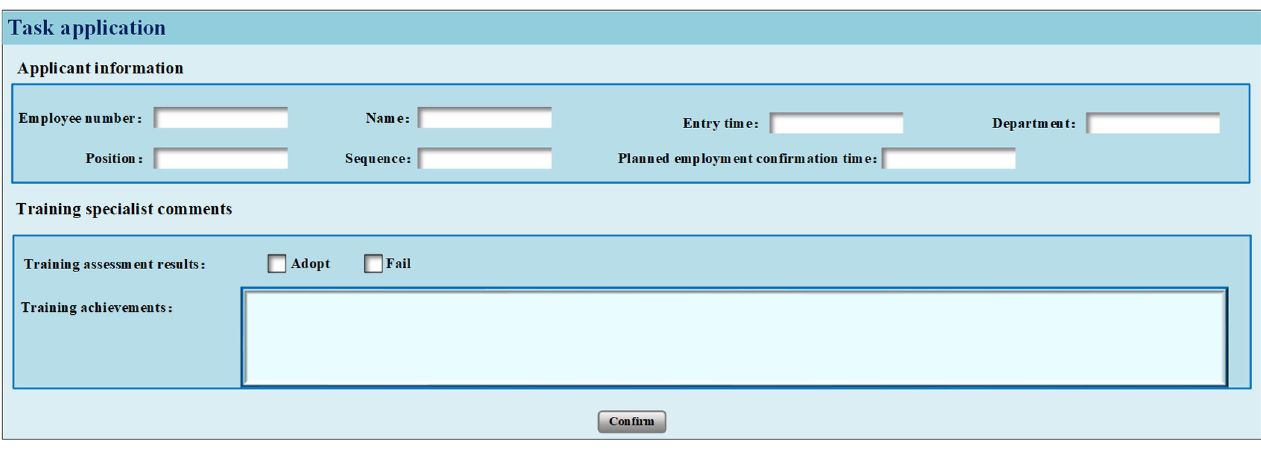
Fig 15. The interface of training management.